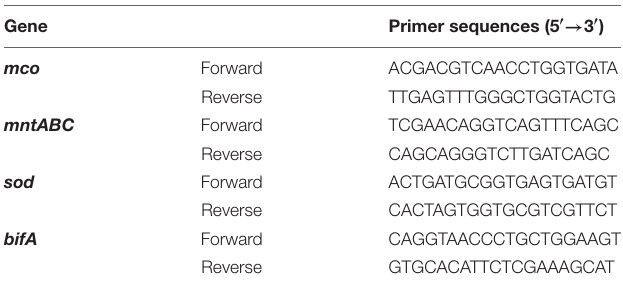
TABLE 1 | The primer sequences for